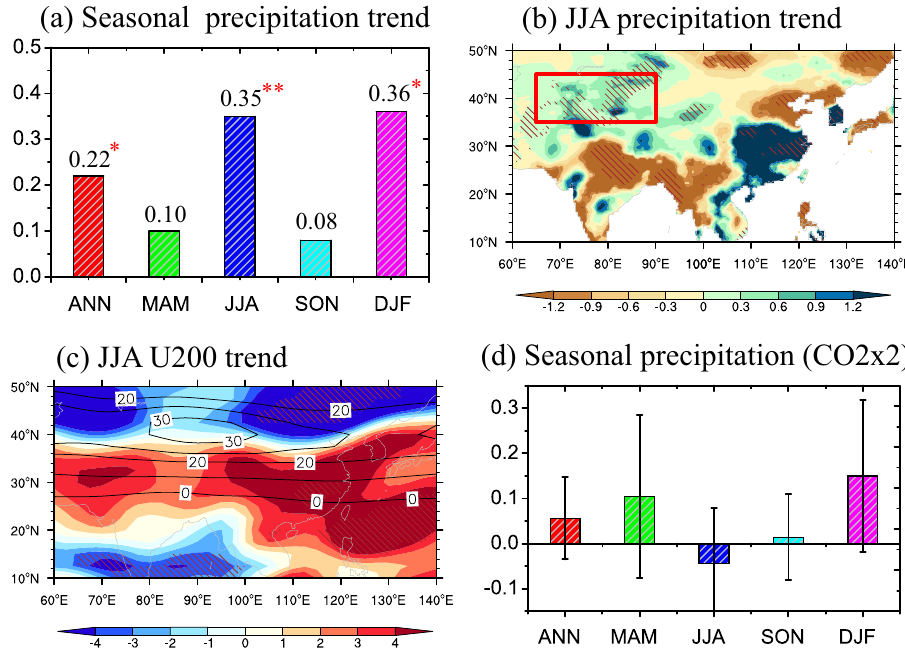
Fig. 1 Precipitation and westerly wind (U200) trends in recent decades over Arid Central Asia (ACA). a Seasonal precipitation trends (mm day − 1 per 100 years) over ACA in annual (ANN), March-May (MAM), June-August (JJA), September-November (SON), December-February (DJF) from 1961 to 2005 based on CRU TS V4.04. Spatial pattern in trends of ( b ) JJA precipitation and ( c ) JJA westerlies at 200 hPa (U200, m s − 1 per 100 years) during the same period (NCEP/NCAR Reanalysis 1). d Seasonal changes induced by GHGs (CO2x2) in precipitation (mm day − 1 ) for the multi-model mean (MMM) in PDRMIP. Red box in ( b ) indicates the ACA region and thin black lines in ( c ) show the climatological westerlies. The single and double red stars in ( a ) represent signi fi cance at the 95% and 99% con fi dence level by a standard t test, respectively. Slanted lines in ( b , c ) represent signi fi cance at the 95% con fi dence level. Error bars of MMM in ( d ) represent the standard deviation among the PDRMIP